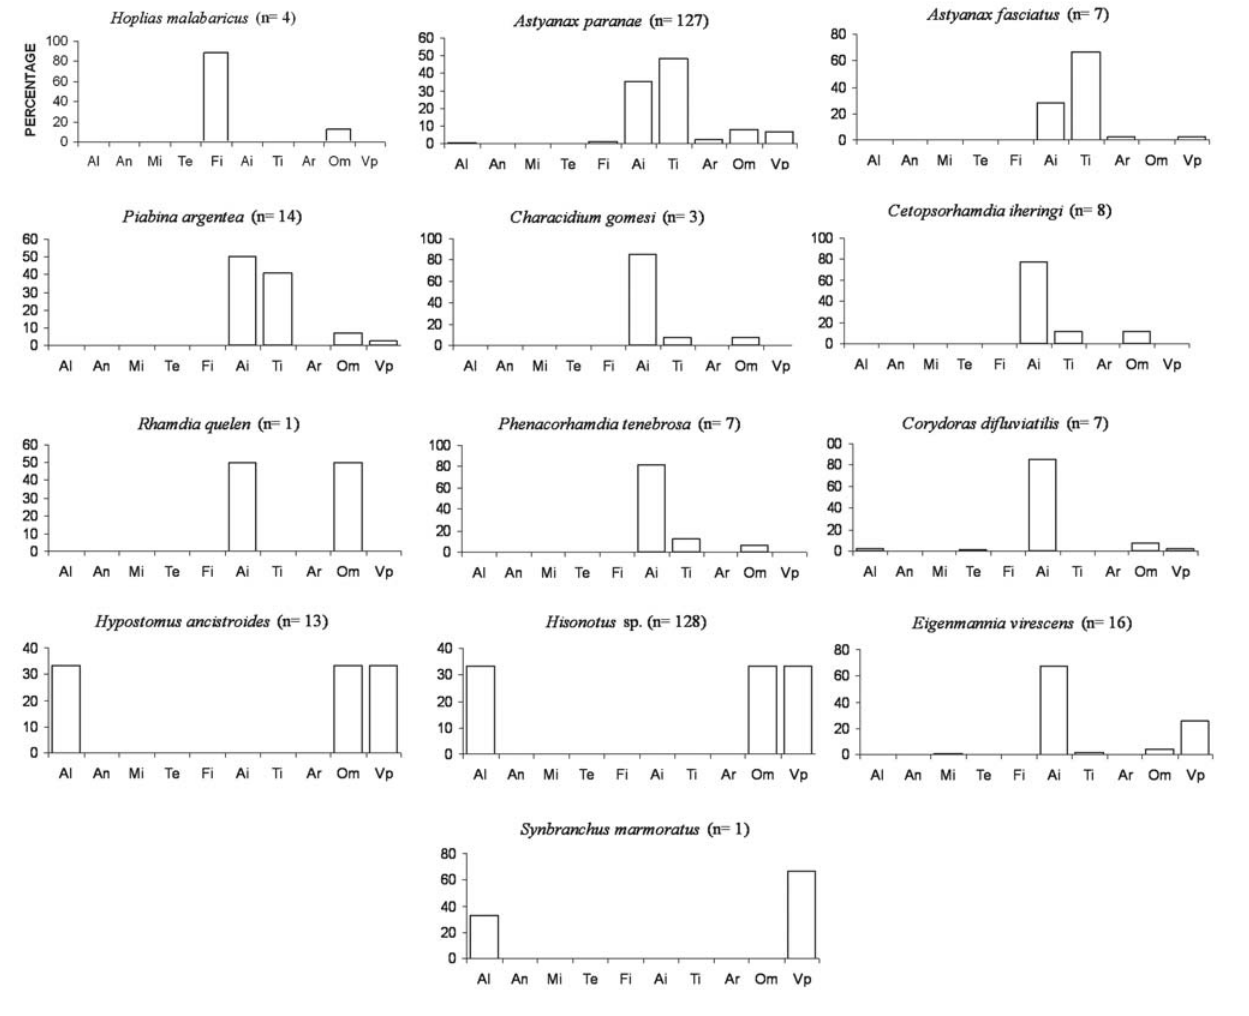
Fig. 4. Percent composition of the gut contents of the fish species with the food items grouped in the following broad categories: the autochthonous - Al = algae, An = anelideos, Mi = micro-crustaceans, Te = thecamoebas, Fi = fishes and fish scales, Ai = aquatic insects; and the allochthonous - Ti = terrestrial insects, Ar = Arachnidae, Om = organic matter and Vp = debris of vascular